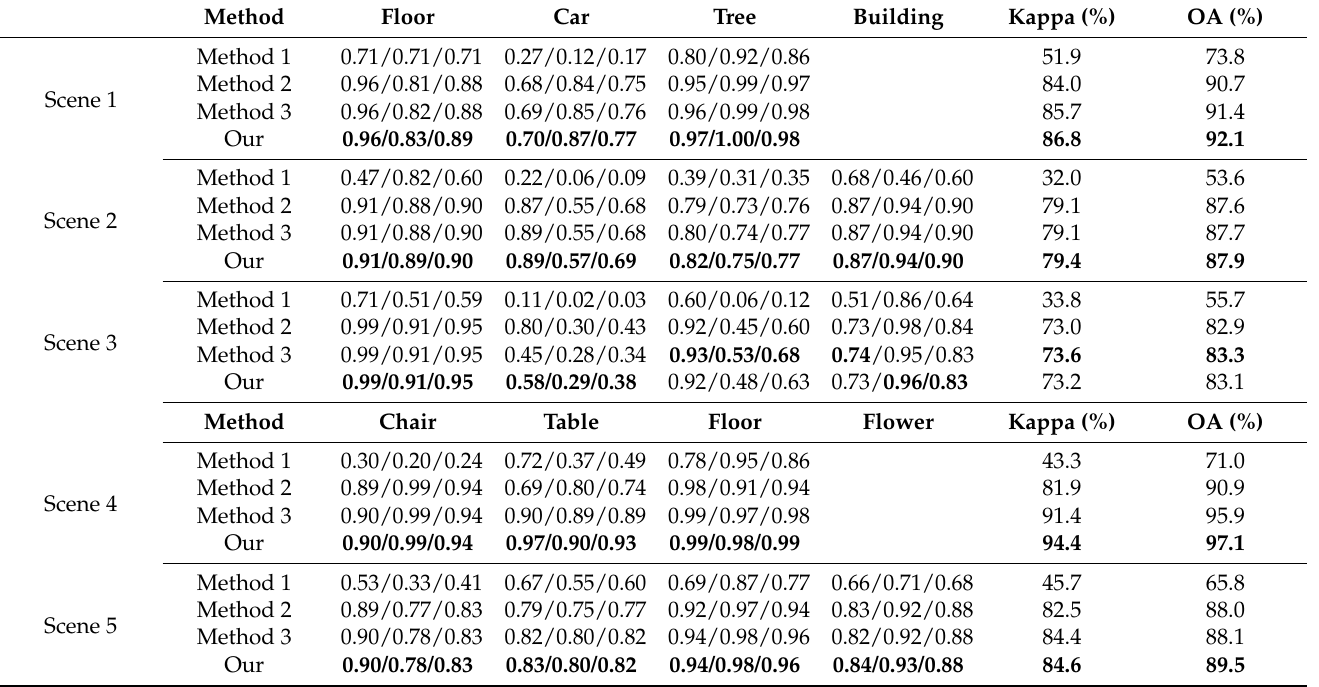
Table 6. Comparison of the classification effects of ground objects and ground objects in each scene with precision/recall/F 1 - scores. For each scene, bold font indicates the best results of each